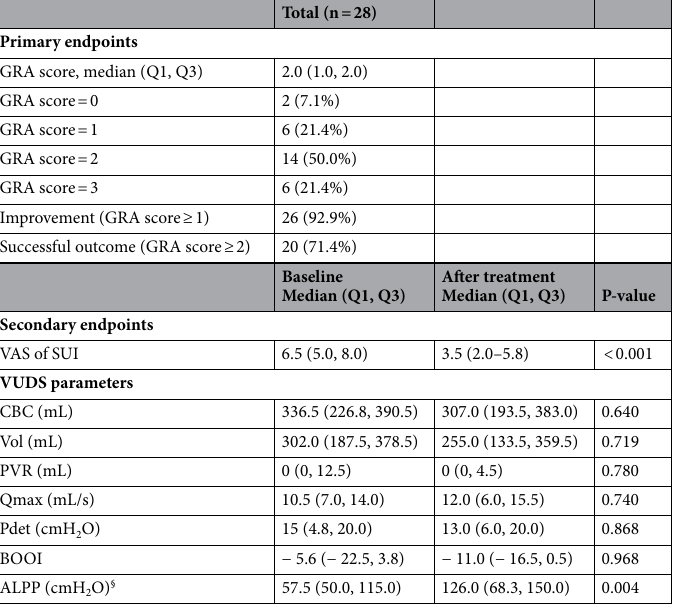
Table 1. Clinical outcomes and change of urodynamic parameters after platelet-rich plasma urethral sphincter injection treatments. ALPP abdominal leak point pressure; BOOI bladder outlet obstruction index; CBC cystometric bladder capacity; GRA global response assessment; Pdet detrusor pressure at maximum flow rate; PVR postvoid residual; Qmax maximum flow rate; VAS of SUI visual analogue scale of stress urinary incontinence severity; Vol voided volume; VUDS videourodynamic study. § Nine patients in the pre-treatment stress test, and fourteen patients in post-treatment stress tests during VUDS did not demonstrate urinary leakage (i.e., no valuable ALPP), and the ALPP values of these patients were excluded for